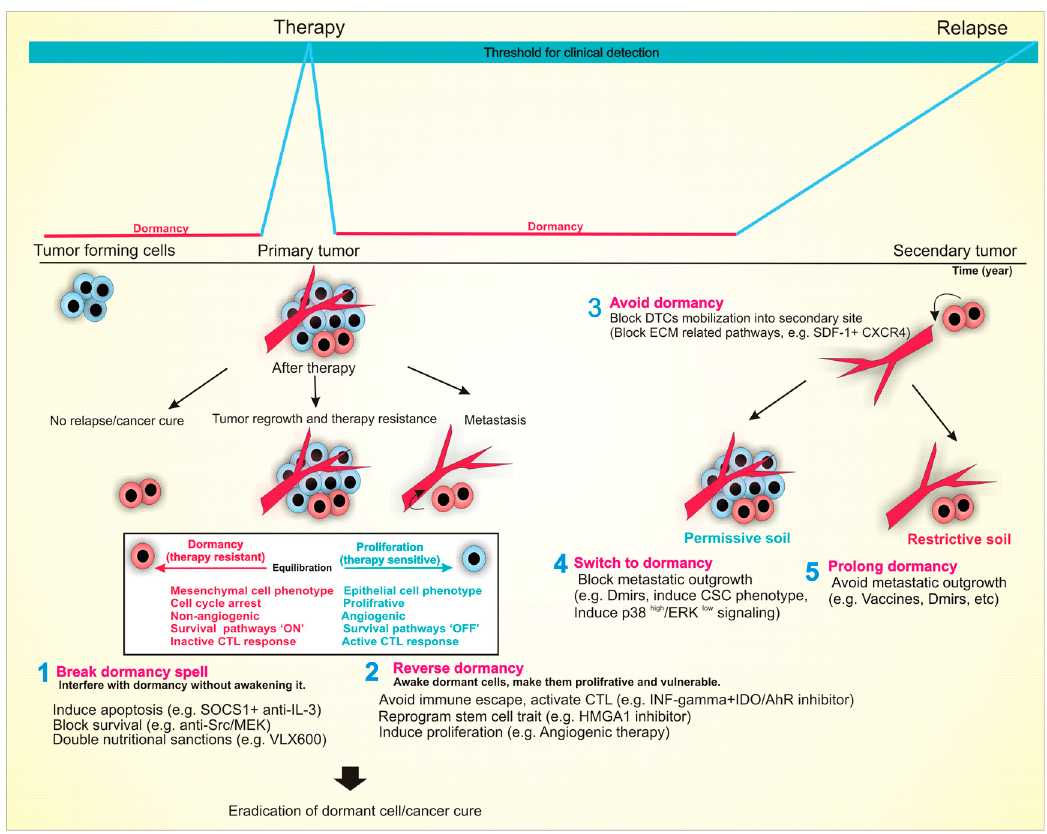
Figure 3. Tumor dormancy as a therapeutic opportunity to fight cancer back.